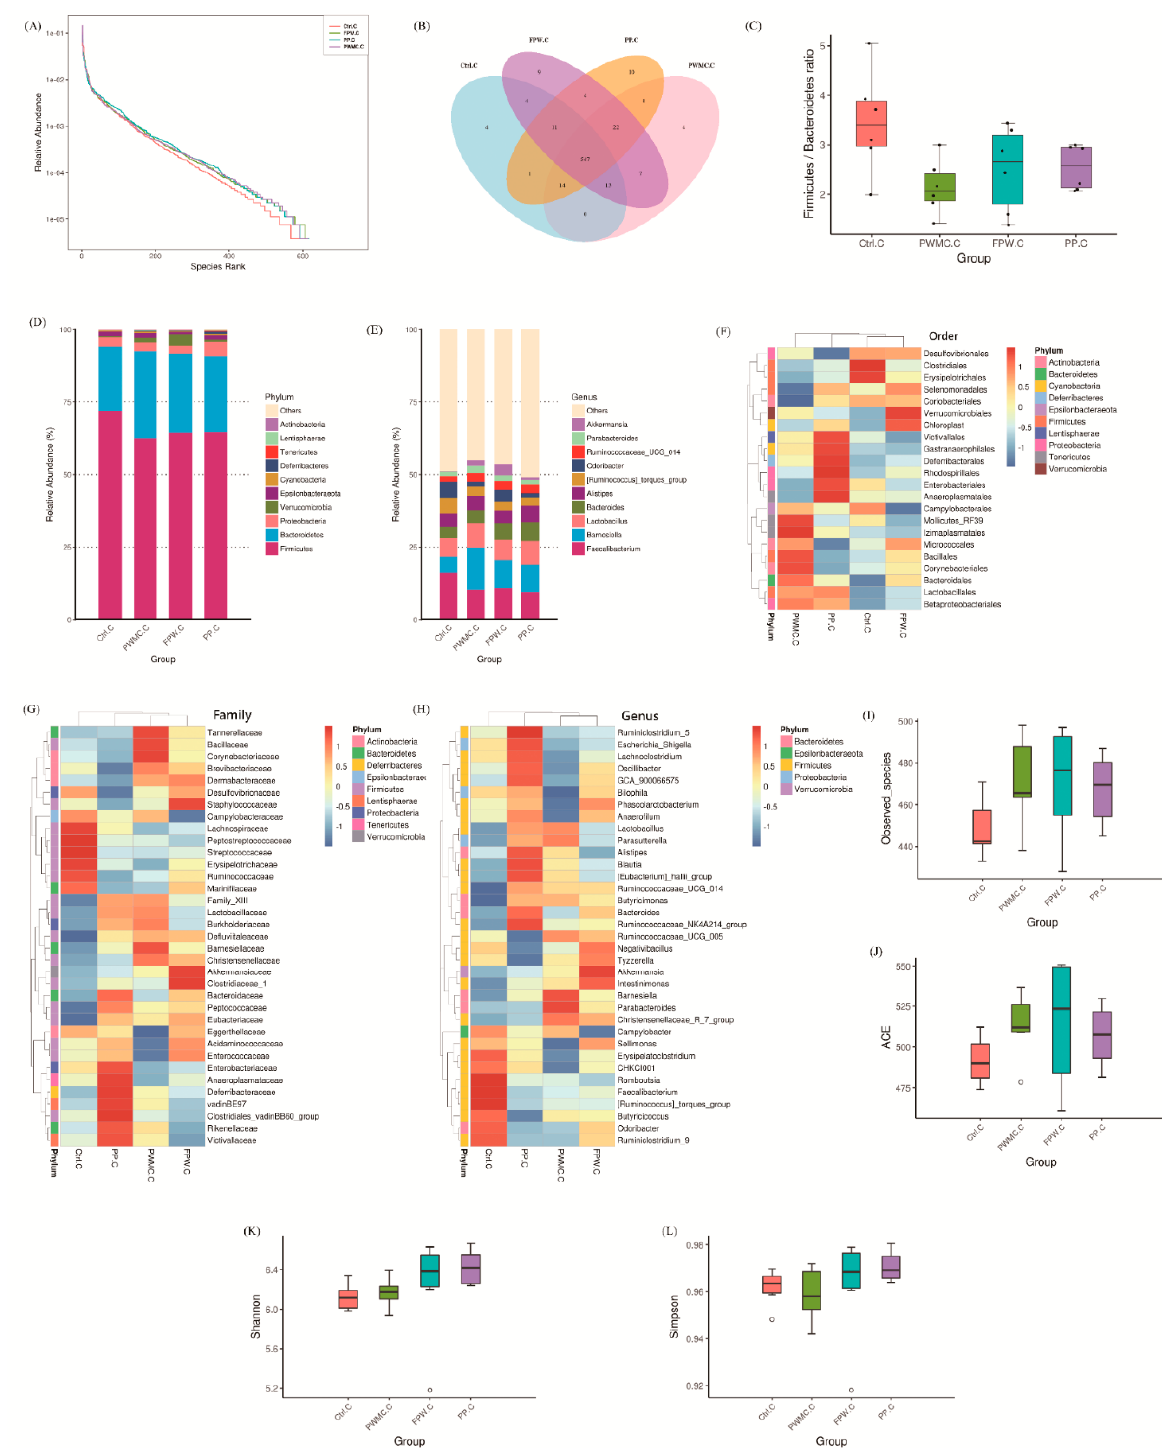
Figure 3. The 35–day–old broilers’ cecum microbiota influenced by a corn–soybean basal diet (Ctrl), Pennisetum pur – pureum Schum No. 2 waste mushroom compost (PWMC), Saccharomyces cerevisiae fermented PWMC (FPW), and Pennise – tum purpureum Schum No. 2 (PP). ( A ) Microbe relative abundance; ( B ) Microbe Venn diagram; ( C ) Firmicutes to Bacteroide–tes ratio; ( D , E ) Relative abundance of each microbe in the broilers’ cecum at the phylum ( D ) or genus ( E ) level; ( F – H ) Taxa heatmap of cecum microbes according to order ( F ), family ( G ) and genus ( H ). ( I – L ) Alpha diversity of 35–day–old broilers’ ileum microbes in each treatment; ( I ) Observed species, ( J ) Abundance-based coverage estimator (ACE), ( K ) Shannon index, and ( L ) Simpson index. Results are means of six samples obtained from the individual birds from the control and experimental groups ( p <